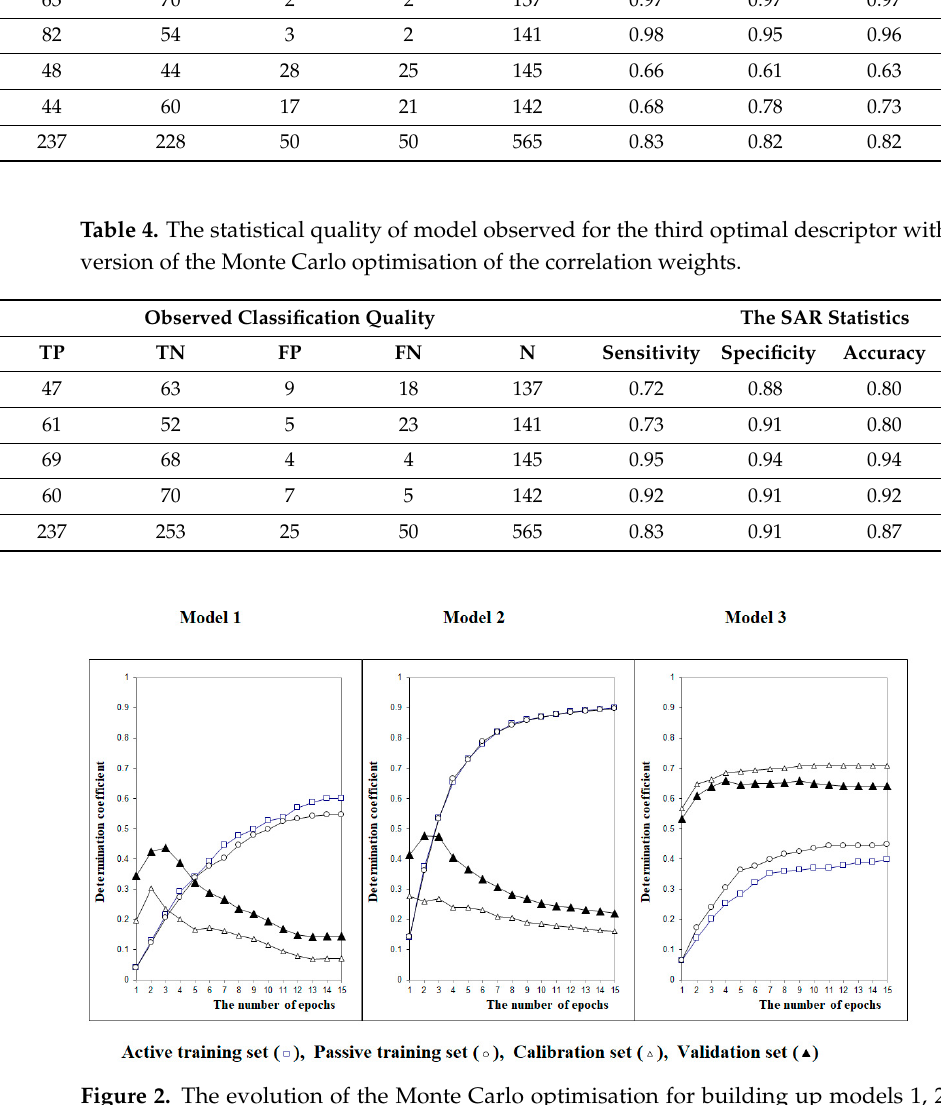
Figure 2. The evolution of the Monte Carlo optimisation for building up models 1, 2 and 3 with different numbers of di ff erent numbers of epochs.